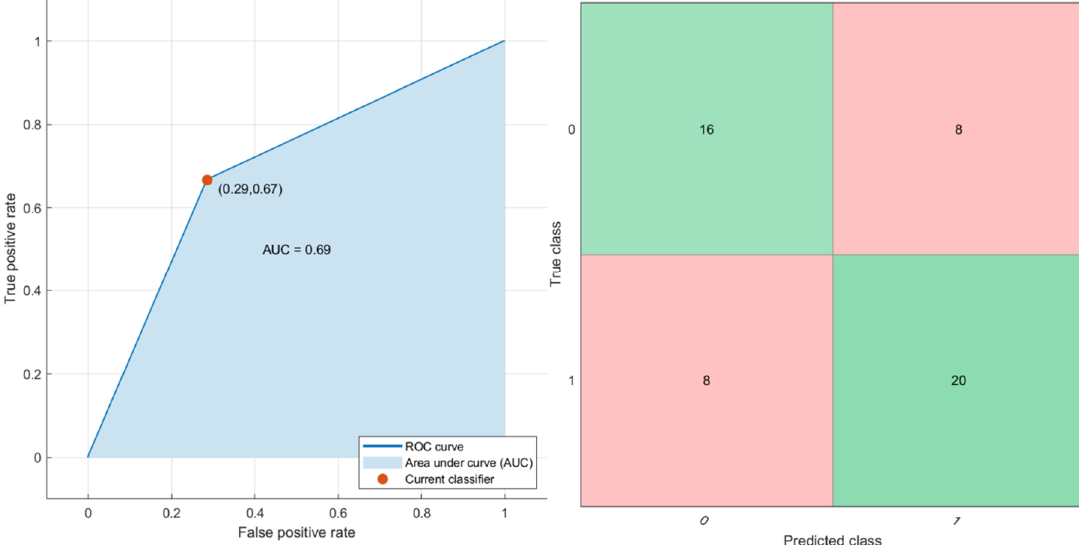
Figure 5. ROC curve and confusion matrix of the KNN tested considering the predictors derived by the feature selection procedure (mean value of S0, the standard deviation value of MK, FP and of DT).